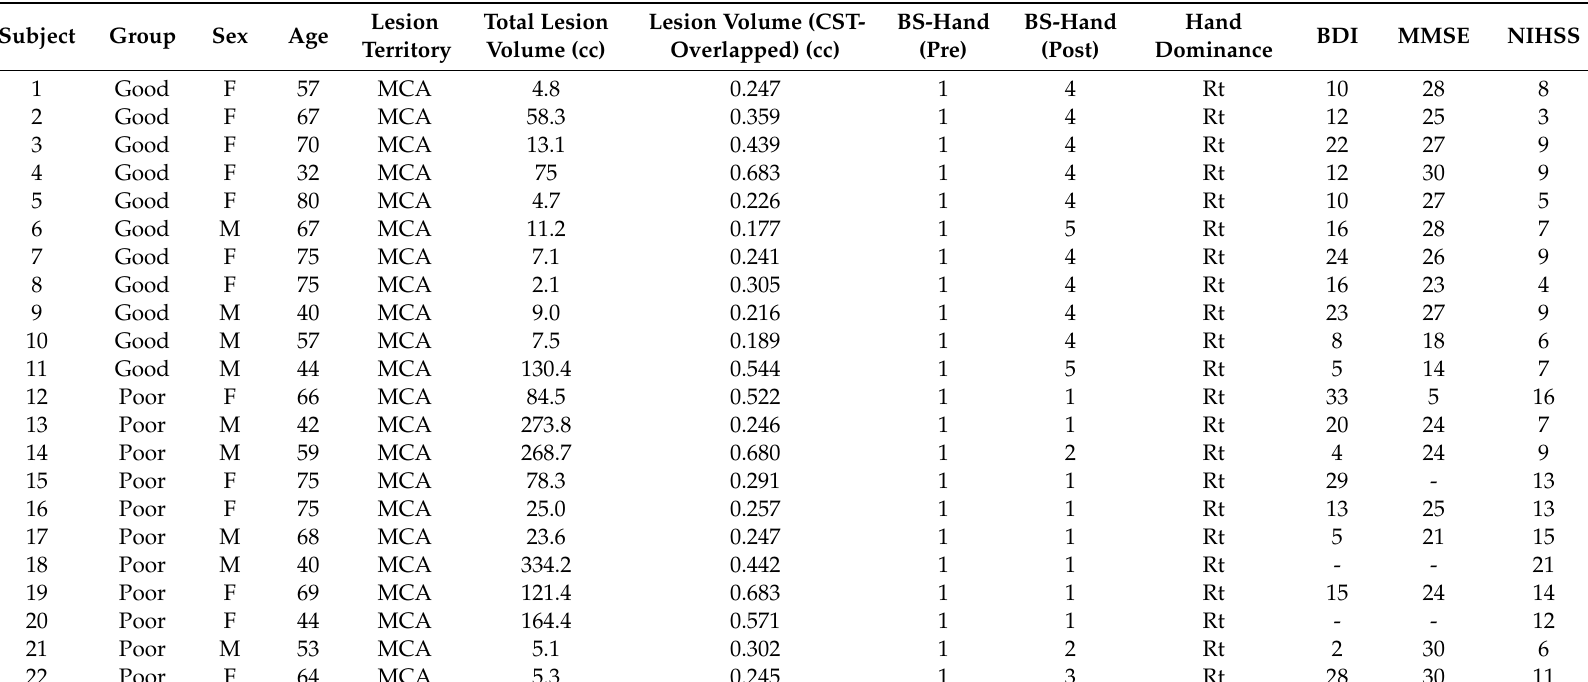
Table 1. Demographics and baseline characteristics of enrolled